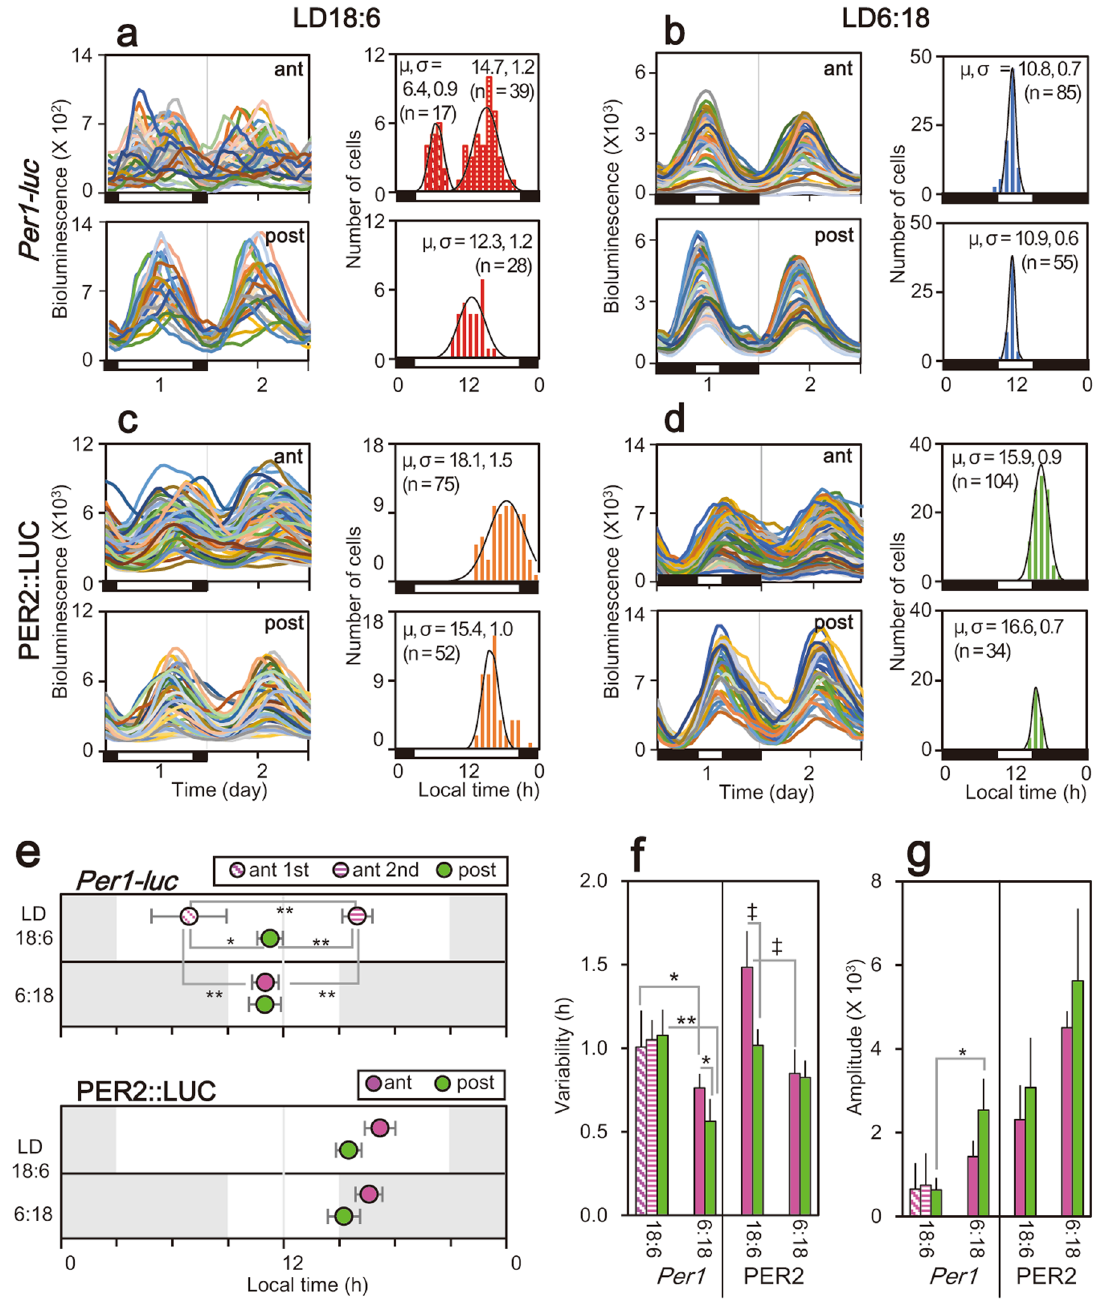
Figure 2. Circadian phase, variability of circadian peak and amplitude of the bioluminescence rhythms in cell- size regions of interest (ROI). ( a , b , c , d ) Forty-eight hour profiles of bioluminescence rhythms in cell-seize ROI and temporal distributions of circadian peaks on the first culture day for Per1-luc ( a , b ) and PER2::LUC ( c , d ) of the anterior (upper panel) and posterior (lower panel) SCN in each photoperiods. A single or double Gaussian curve fitted to a histogram of circadian phase is indicated by a black curve superimposed on a histogram. Median ( μ ) and variance ( σ ) of a Gaussian curve are inserted in each panel. ( e ) Mean medians (n = 5) in the anterior (pink circle) and posterior (green circle) SCN with SD. Two medians detected for the circadian Per1-luc rhythm in the anterior SCN from LD 18:6 are labelled as the 1st and 2nd peak. Shaded and white areas are the dark and light phases of LD on the day of tissue harvest. ( f ) Variability of circadian peak in terms of variance of Gaussian curve was evaluated in the regions of the SCN as well as in different photoperiods for Per1-luc (left) and PER2::LUC (right). Colors of vertical columns mean the clusters of circadian rhythms indicated in the panel e. ( g ) Mean amplitudes were similarly illustrated to the panel f of circadian rhythms obtained by CCD with a comparable sensitivity ( Per1-luc : LD18:6, n = 4; LD6:18, n = 3. PER2::LUC: LD18:6, n = 3; LD6:18, n = 3). ( e–g ) ** P < 0.01, * P < 0.05, one-way ANOVA with a post-hoc Tukey-Kramer test. ‡ P < 0.01, two-way ANOVA with a post-hoc Tukey-Kramer